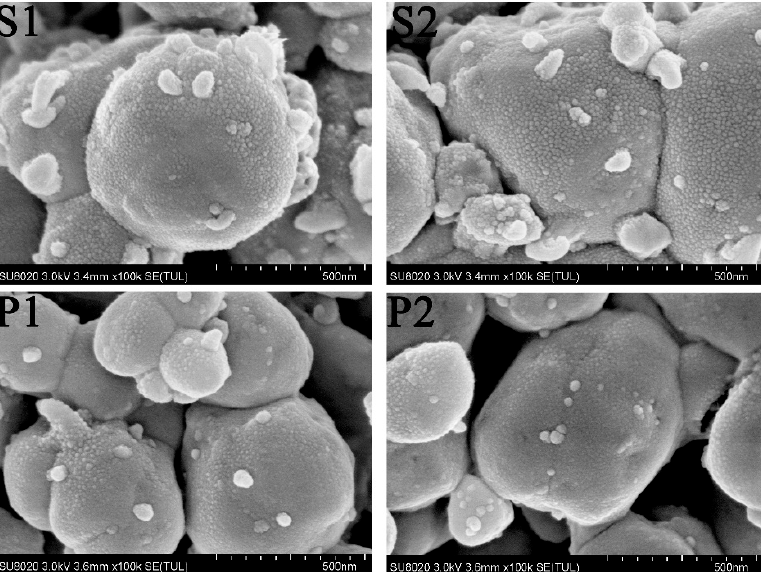
Figure 2. Micrographs of the prepared samples with fatty acid: ( S1 , S2 ) SA/AgBr microcapsules and ( P1 , P2 ) PA/AgBr microcapsules.